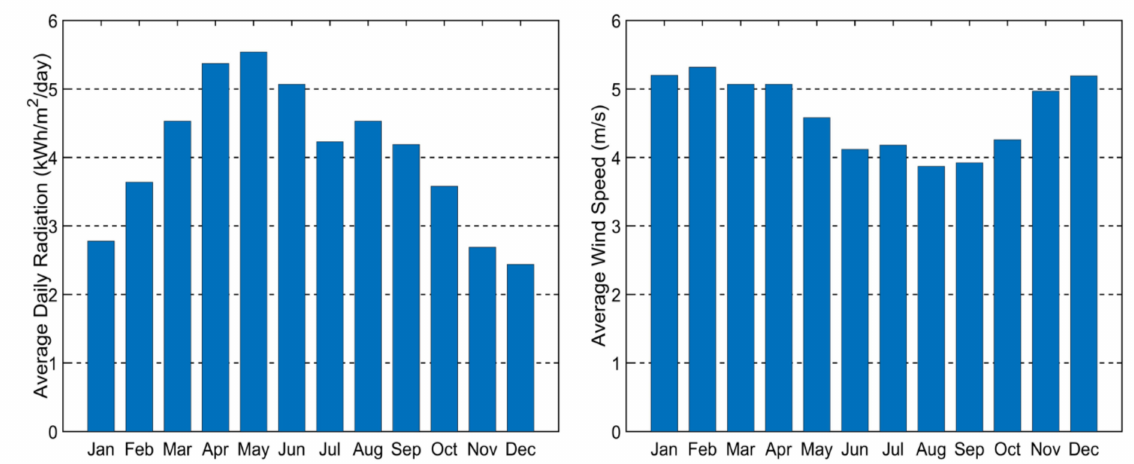
Figure 15. The average daily radiation and average wind speed at Deokjeok Island.